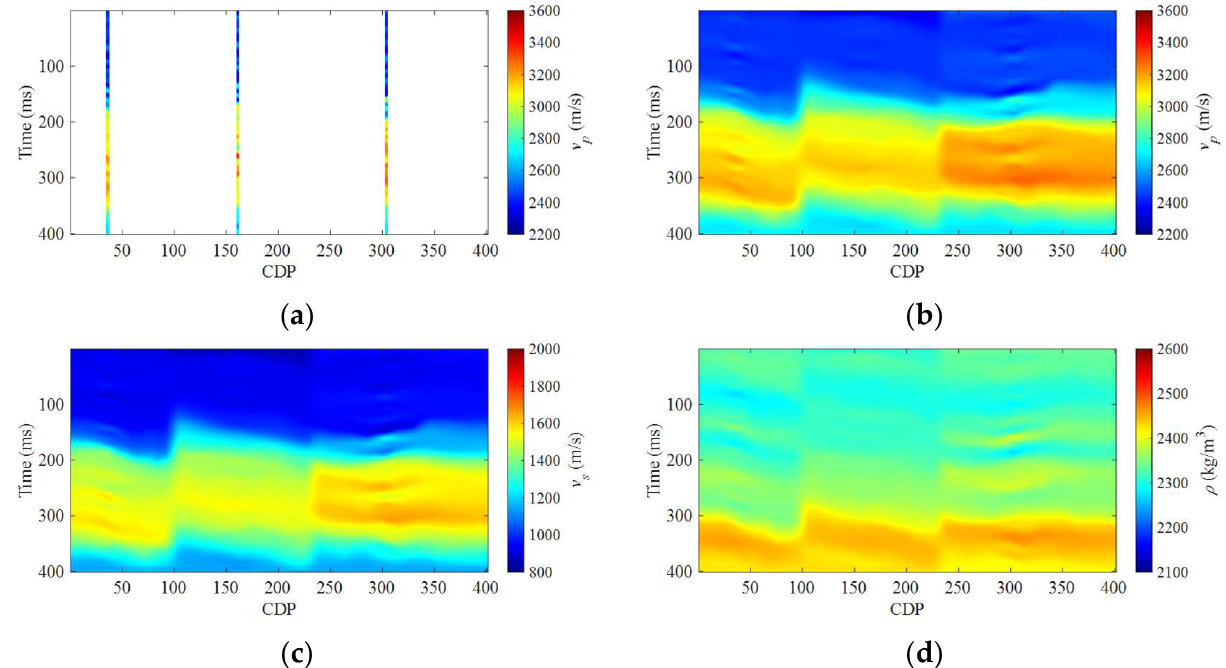
Figure 13. ( a ) The locations of three wells and interpolation results of ( b ) v p , ( c ) v s , and ( d ) ρ by KI.